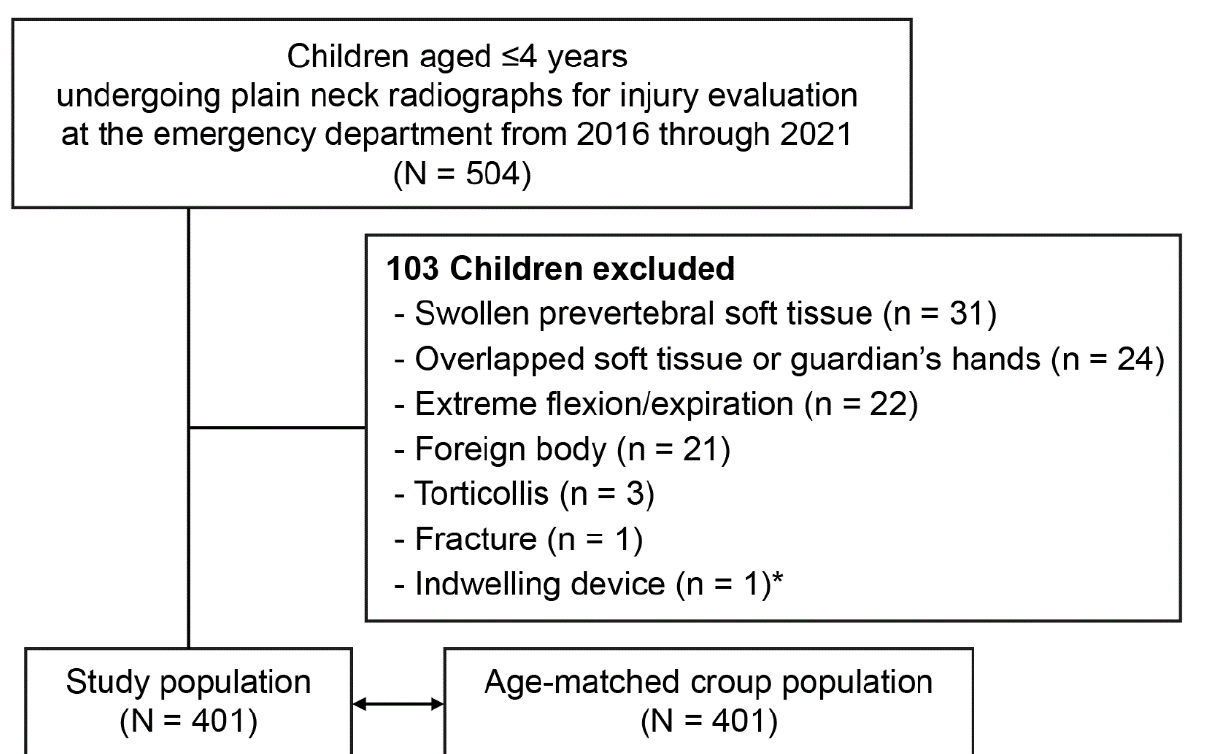
Figure 2. Flowchart for the study population. * Ventriculoperitoneal shunt.